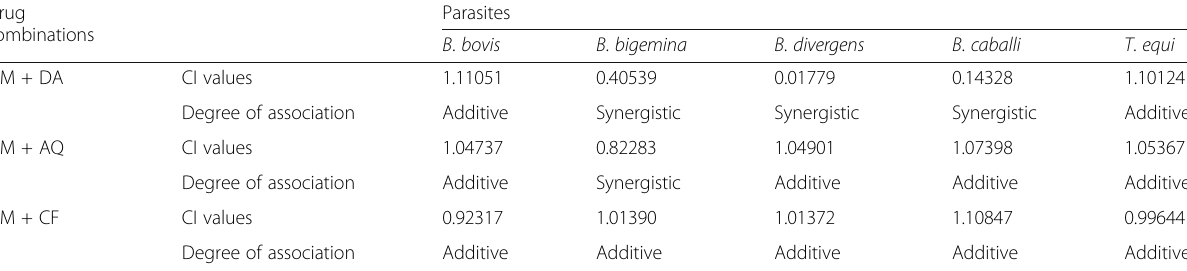
Table 3 The effect of ivermectin with diminazene aceturate, atovaquone, and clofazimine against Babesia and Theileria parasites in vitro